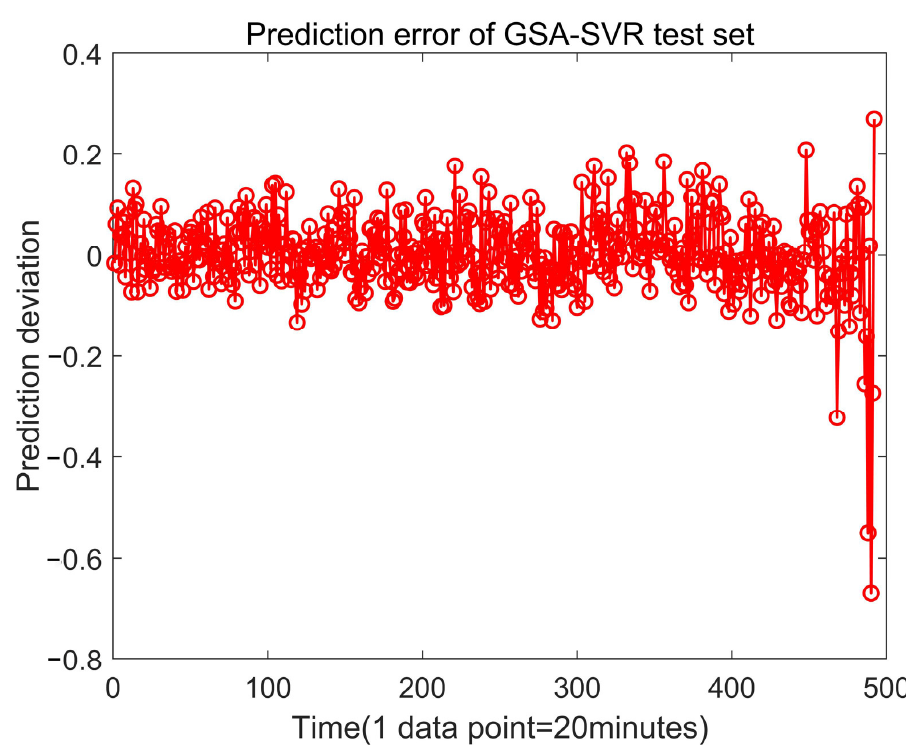
Figure 15. The prediction error of the test set by GSA-SVR.